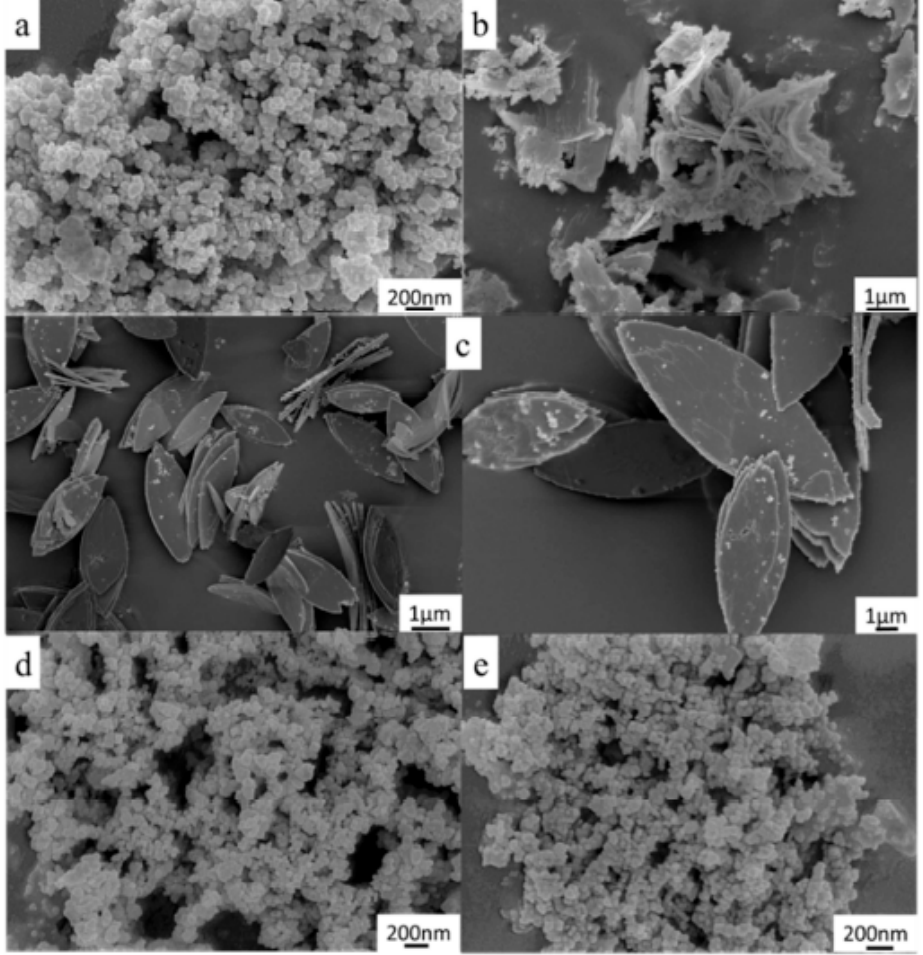
Figure 15. Micrographs showing the dependence of Nd 2 O 3 nanoparticles shape on the concentration of N -(3-cocoamidopropyl)-betaine (CAPB), parts ( a – d ). Part ( e ) shows the nanoparticles fabricated in the absence of the surfactant [204]. Reprinted with permission from ref. [204]. Copright 2021